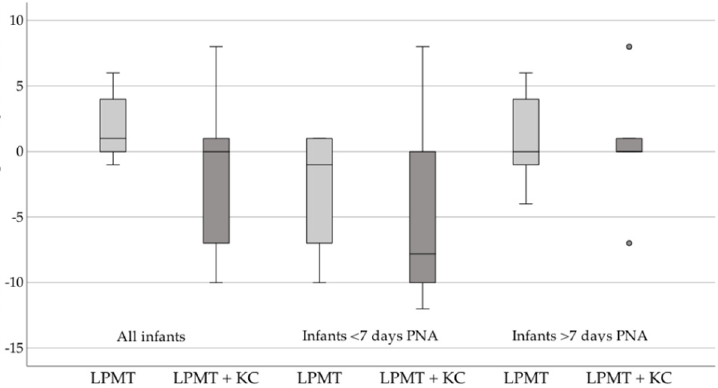
Figure 4. Delta General Movement Optimality Score (GMOS) for all infants, infants <7 days PNA and infants >7 days PNA. Grey points indicate the outliers of this study. GMOS, General movement optimality score; LPMT, live-performed music therapy; KC, kangaroo care; PNA, postnatal age.